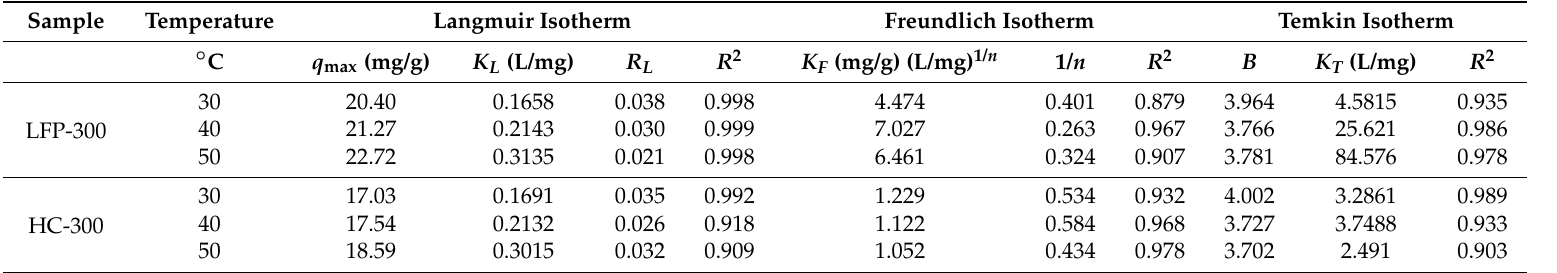
Table 4. Isotherm Model parameters at Different Temperature for LFP-300 and